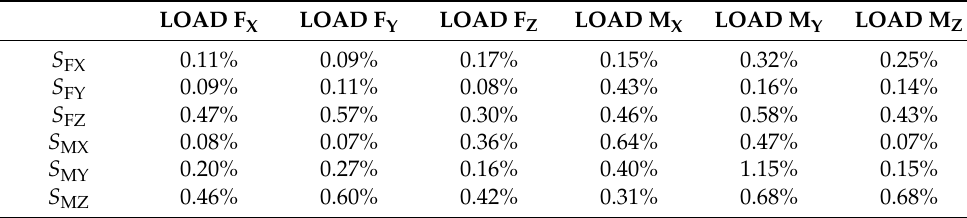
Table 11. Analysis of average measurement error and crosstalk of 32 strain gage arrangement with integrated